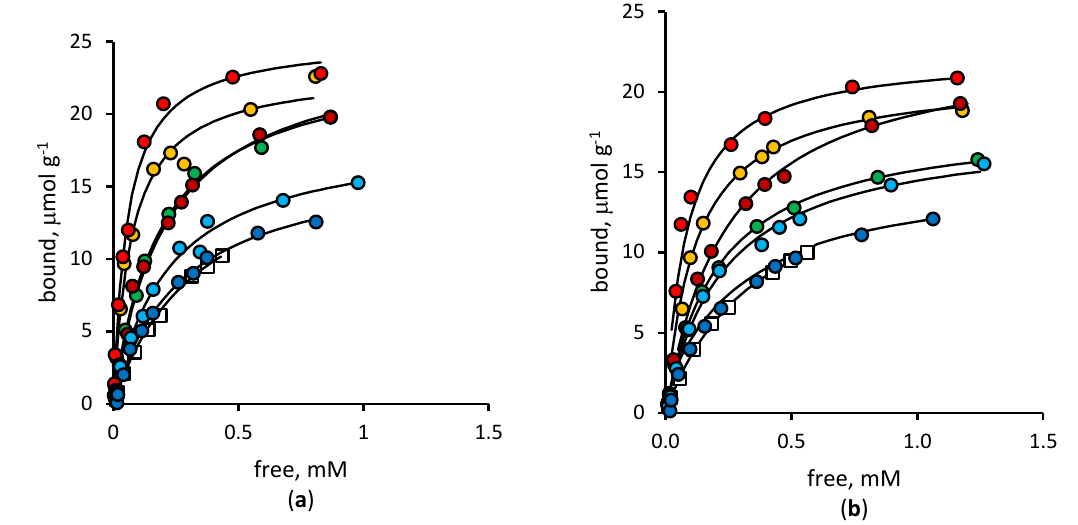
Figure 2. Binding isotherms for NIP (open squares), MIP-0 (green circles), MIP-5 (yellow circles), MIP-10 (red circles), MIP-15 (dark red circles), MIP-20 (cyan circles), MIP-30 (blue circles). ( a ) Diclofenac; ( b ) Mefenamic acid.